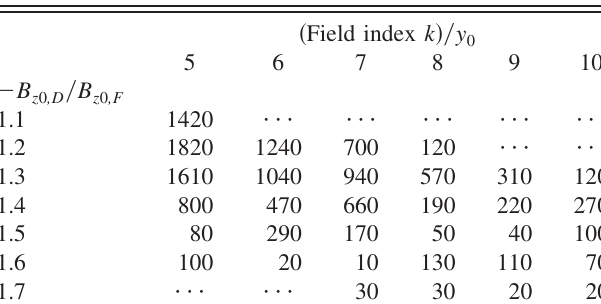
TABLE II. Acceptance of the FFAG-BTL [ (cid:2) mm mrad ] un- normalized.